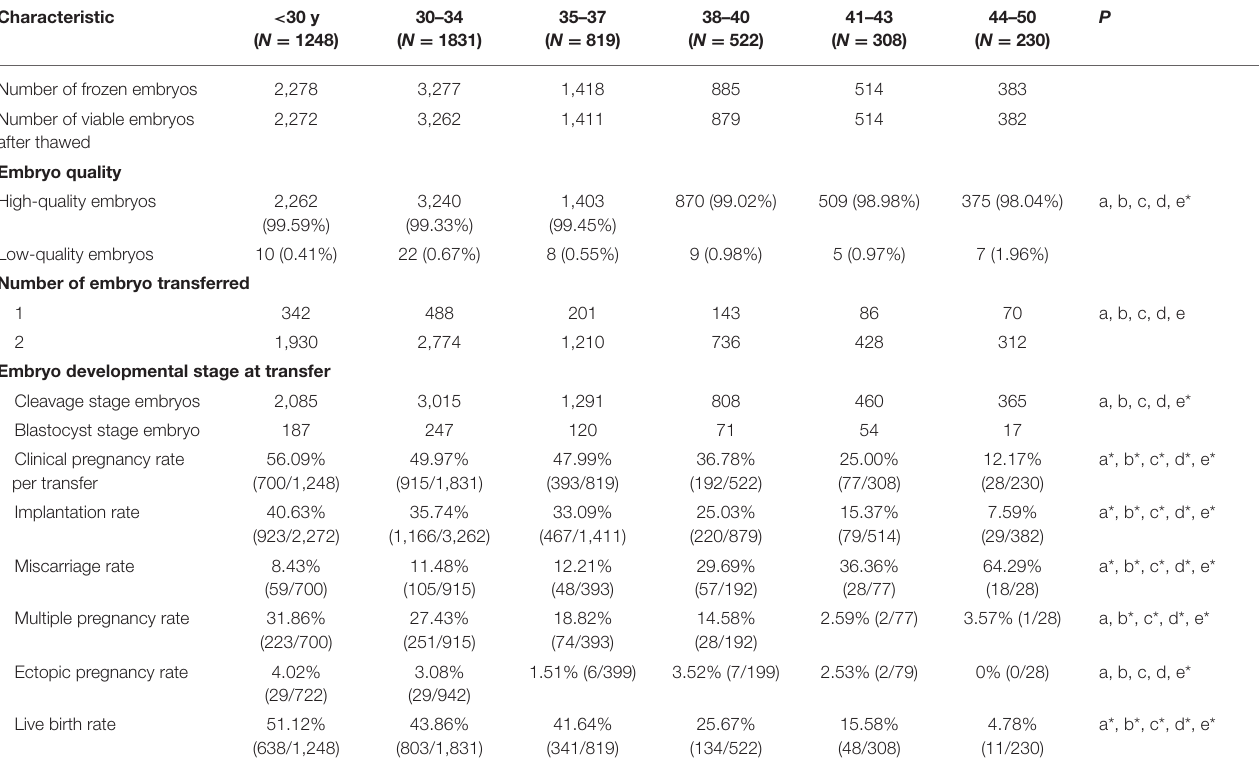
TABLE 2 | Reproductive outcomes biy age